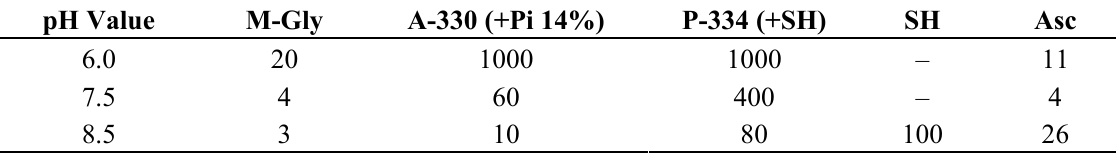
M-Gly: mycosporine-glycine Figure 3(2a), A-330: asterina-330 Figure 4(3g), P-334: porphyra-334 Figure 4(3a), SH: shinorine Figure 4(3e), Pi: palythine Figure 4(3d), Asc; L -ascorbic acid, –: not determined (too